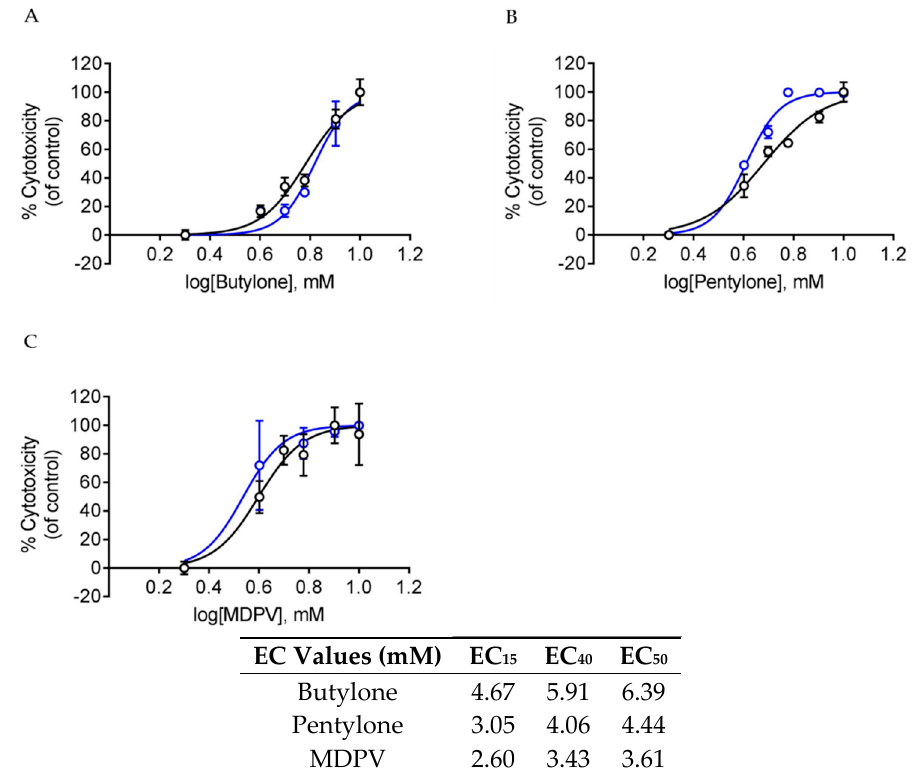
Figure 2. Dose-response curves after the treatment of ( A ) butylone, ( B ) pentylone, and ( C ) MDPV for 24 h; lactate dehydrogenase (LDH) (black) and trypan blue (TB) assay (blue). Data are Mean ± SD obtained from three independent experiments for the TB assay and four independent experiments for the LDH assay. Table: Mean EC 15 , EC 40 , and EC 50 values after 24 h of treatment of butylone, pentylone, and MDPV, obtained from both TB and LDH assays.